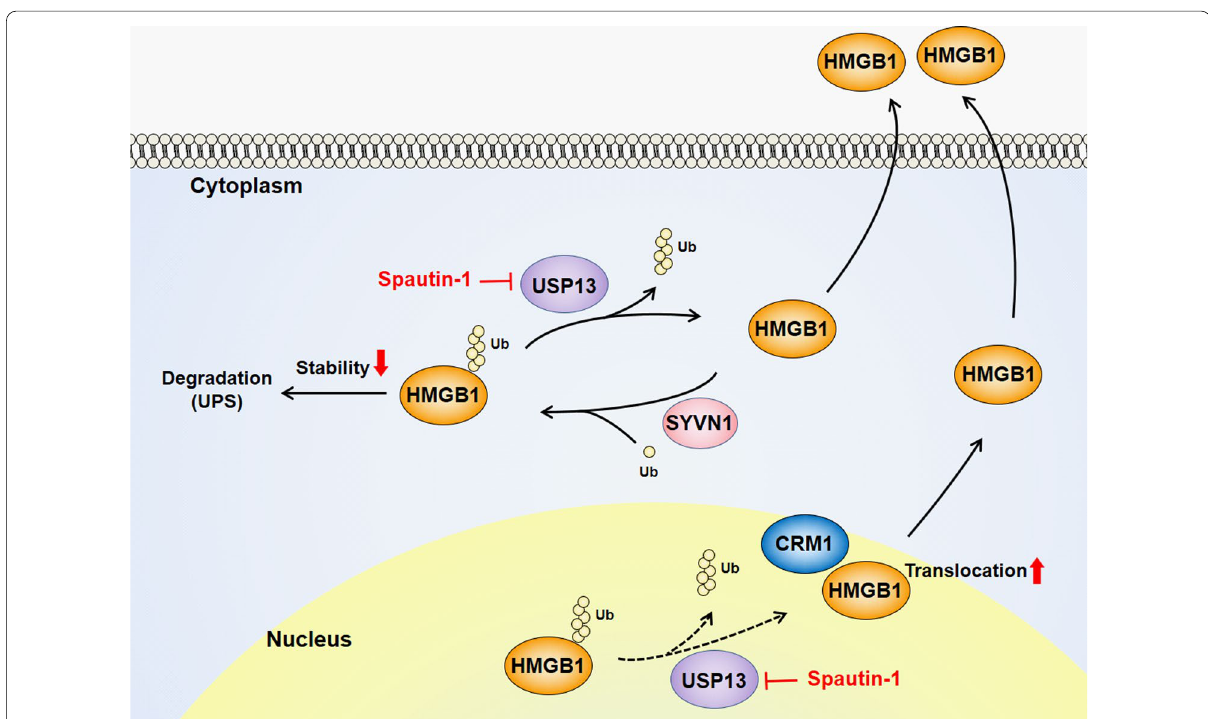
Fig. 7 A model of the regulatory mechanism of HMGB1 by USP13. USP13 regulates HMGB1 stability and nucleocytoplasmic localization via CRM1‑dependent pathway. Consequently, USP13 promotes HMGB1 secretion; this axis can be inhibited by Spautin‑1. E3 ligase of HMGB1 which is used for ubiquitination is not known (X). Synoviolin (SYVN1) is reported as the E3 ligase of HMGB1 using bioinformatics analysis(W Yao et al. 2021). Dotted line is hypothetical pathway in nucleus. UPS ubiquitin–proteasome